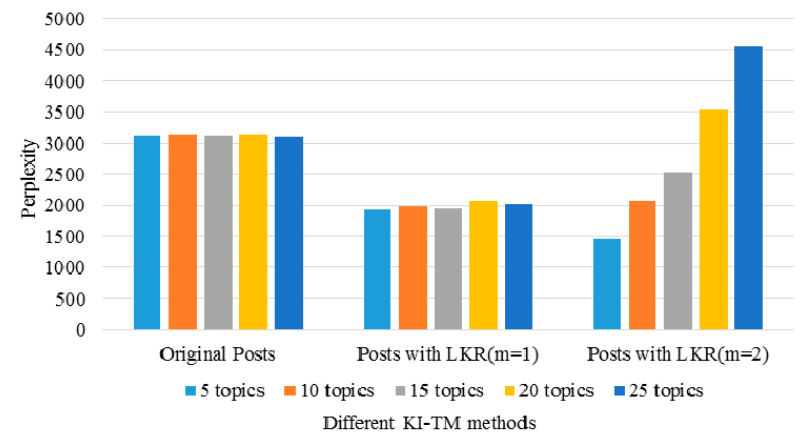
Figure 9. Comparison of the perplexity values of different Latent Dirichlet Allocation (LDA) based methods.